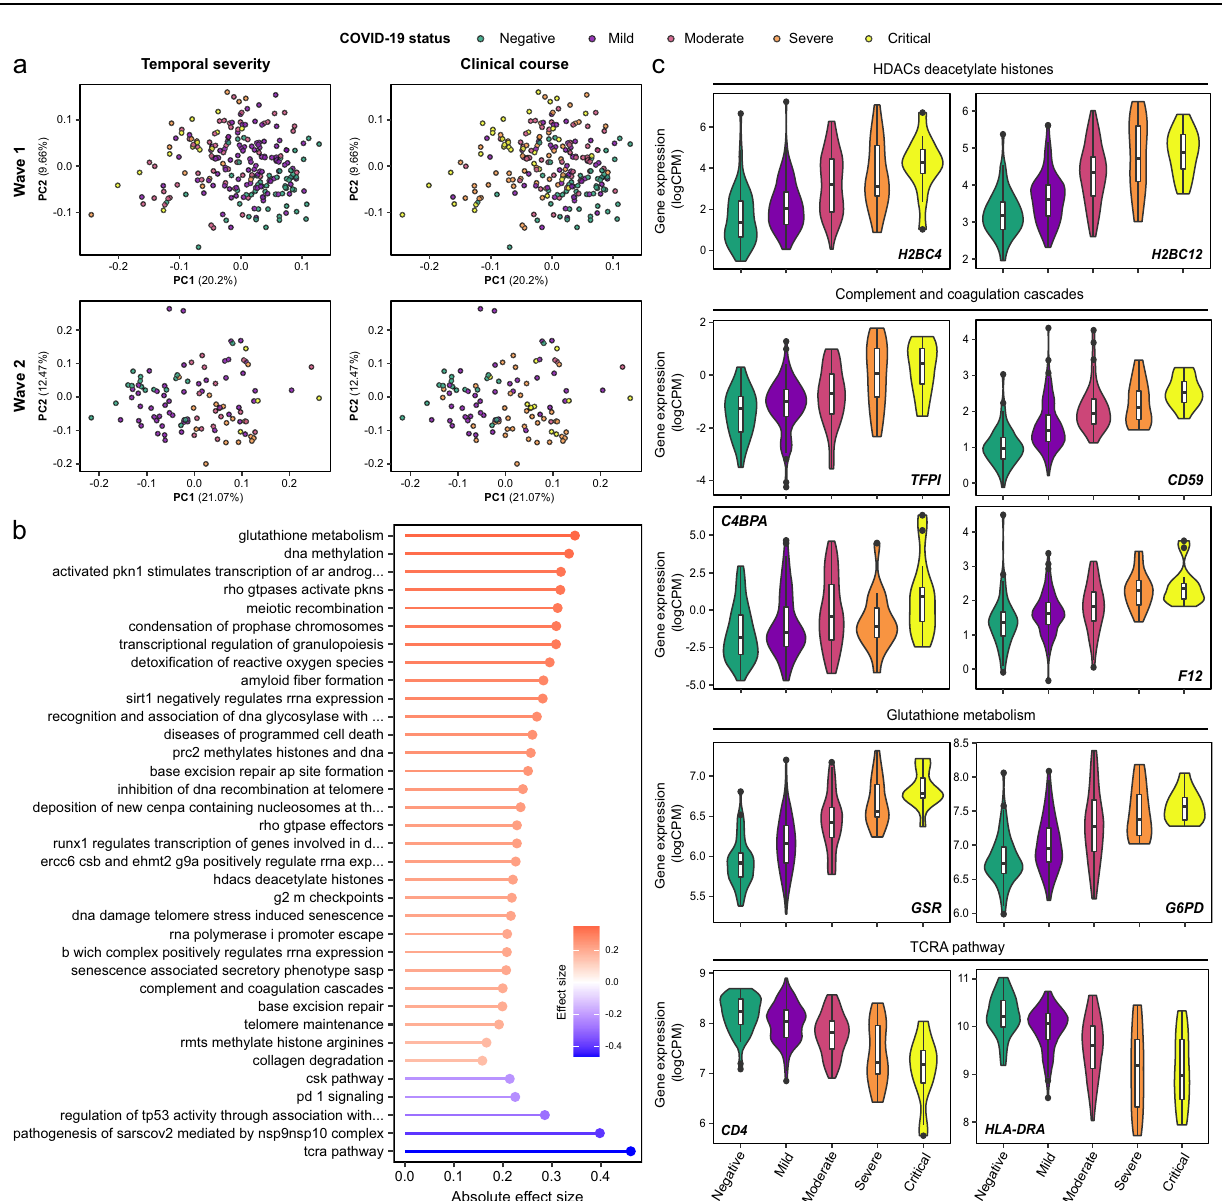
(at time of sample) for selected genes. Shaded areas indicate kernel density esti- mates. For boxplots, centre=median, upper bound=upper quartile (UQ), lower bound=lower quartile (LQ), upper whisker=largest value at most 1.5 * IQR (inter- quartile range) from the UQ, lower whisker=smallest value at most 1.5 * IQR from the LQ, points=samples outsideof the range of the whiskers. Allgenesshown were signi fi cantly associated (1% FDR) with severity in both the Wave 1 and 2 cohorts. Genesaregroupedbymembershiptopathwaysthatweresigni fi cantlyenriched(1% FDR) in